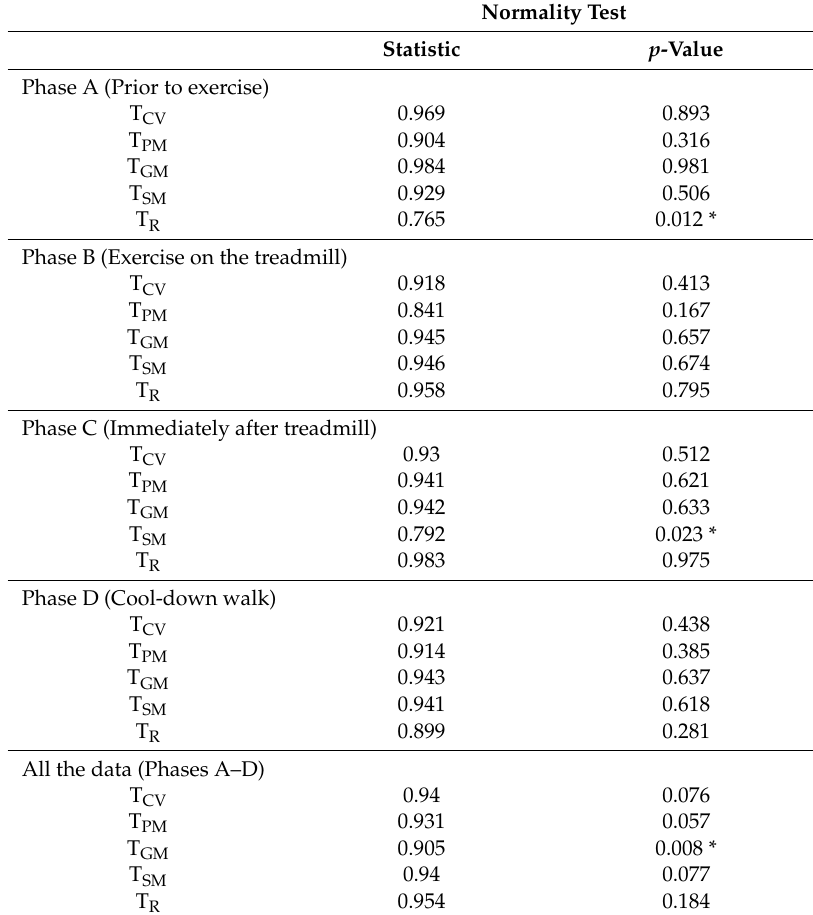
Table A1. Normality tests of body temperature readings of horses before, during, and after treadmill